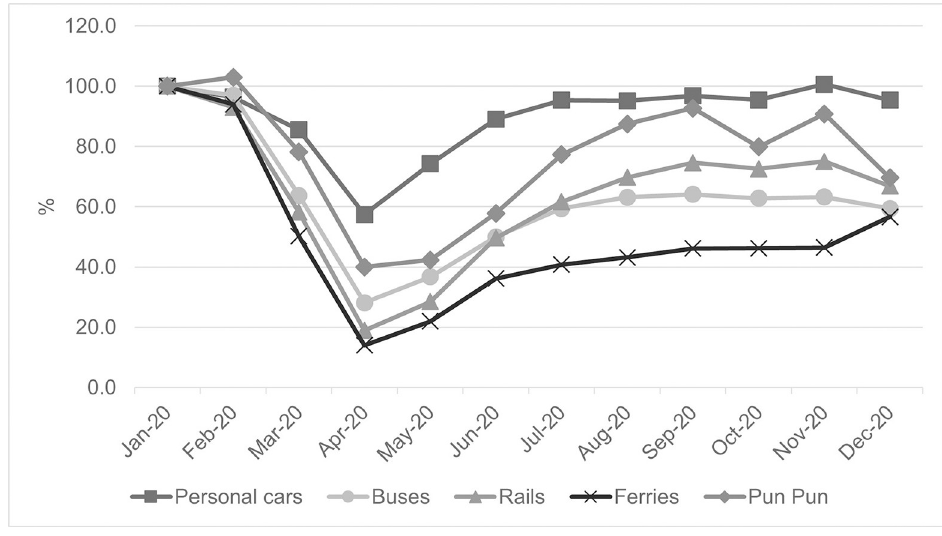
Fig 5. Patterns of various transportation modes in